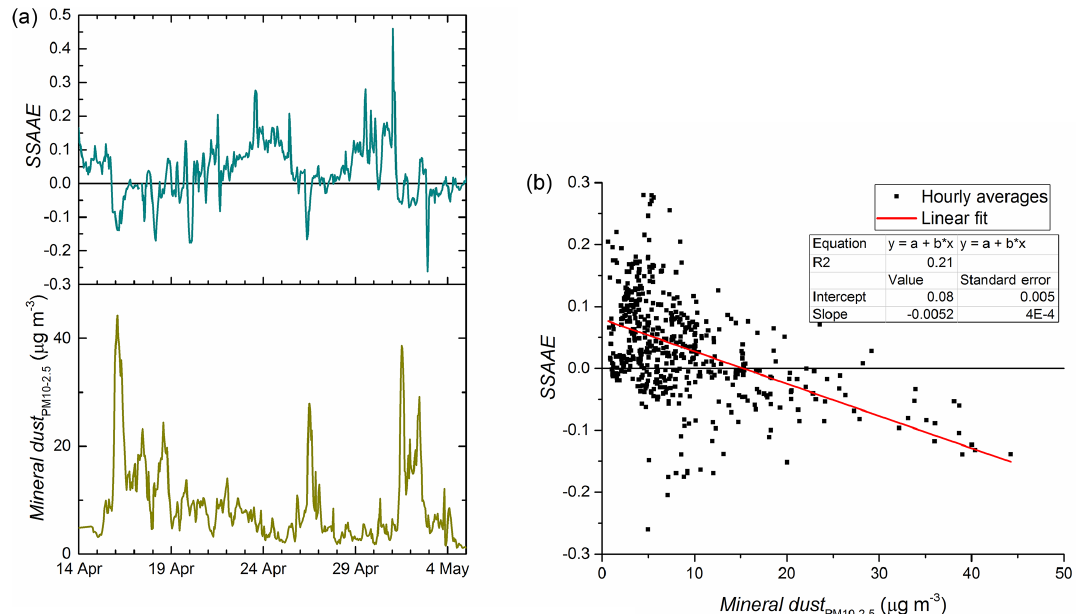
Figure 9. Time series (a) and correlation (b) of the single scattering albedo Ångström exponent (SSAAE) and mineral dust